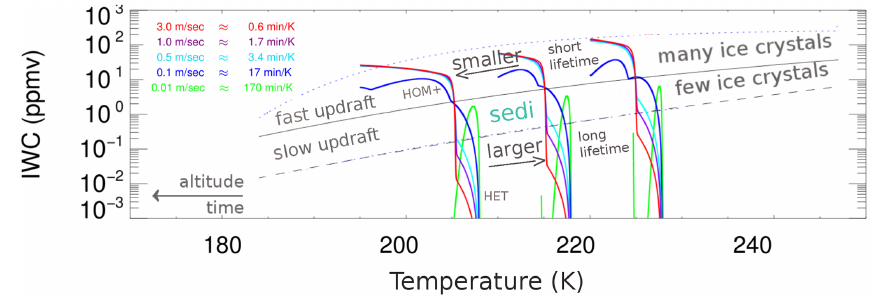
Figure 9. Sketch of the MAID in situ Cirrus guide: two classes of in situ cirrus clouds are identified in the IWC-T parameter space. (1) IWCs below the median IWC line (Schiller et al., 2008; Luebke et al., 2013) mostly stem from slow updraft cirrus. They consist of few, but large ice crystals which are larger the warmer the cirrus is. The first part of these cirrus is determined by HET freezing (indicated in the figure). If the clouds life time is long enough, HOM freezing also starts. Due to the low updrafts, the number of ice crystals produced by HOM freezing does not greatly differ from the HET nucleated ice crystals. Thus, in slow updraft regions the difference in microphysics between HET and HOM formed cirrus is small. (2) High IWCs above the median IWC line are mostly produced by fast updraft cirrus. The time of the HET cirrus part at low IWC is short since the HOM freezing pushes the IWC quickly above the median line. With their large number of small, non-sedimenting ice crystals, these cirrus are microphysically very different from the slow updraft